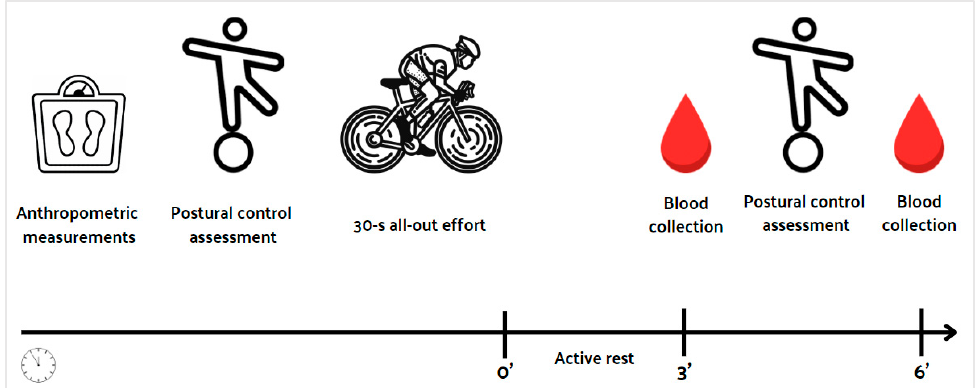
Figure 1. The course of the study.